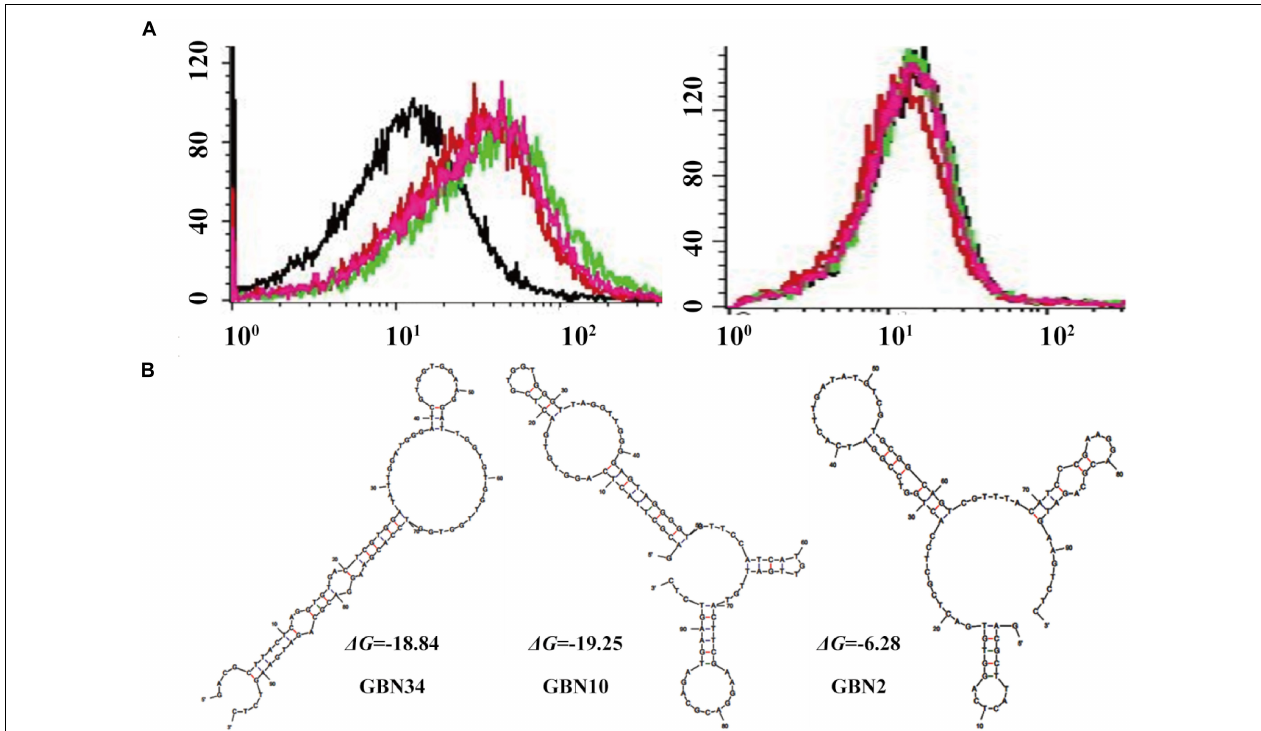
FIGURE 1 | Selection of three aptamers that specifically recognized RGNNV-GB cells by cell-systematic evolution of ligands by exponential enrichment (Cell-SELEX) technology. (A) Binding of FITC-labeled DNA pools to RGNNV-infected GB cells was enhanced after more rounds of selection (left). Black, initial library; red, 9th round of selection; green, 10th round of selection; pink, 11th round of selection. FITC-labeled DNA pools bound to uninfected GB cells served as a control (right). (B) Predicted secondary structures of aptamers (GBN2, GBN10, and GBN34). The stabilities of the aptamer secondary structures were calculated as the free energy values ( (cid:49) G ). TABLE 1 | Identification of ssDNA aptamers. Aptamer Central randomized sequences